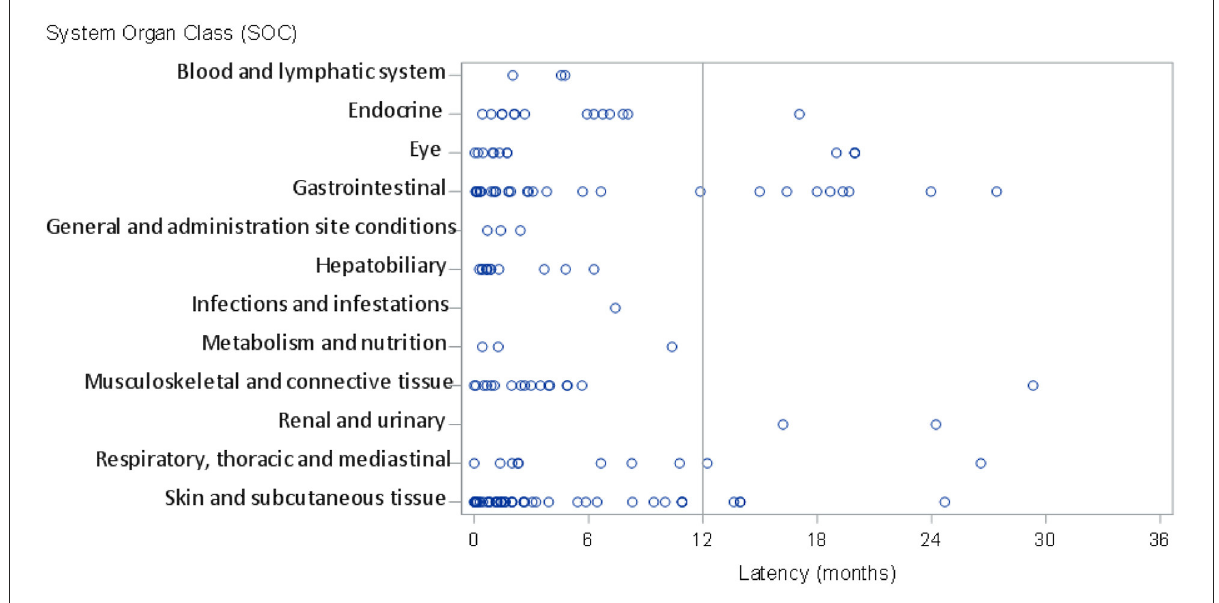
FIGURE3 Latency period of immune-related adverse